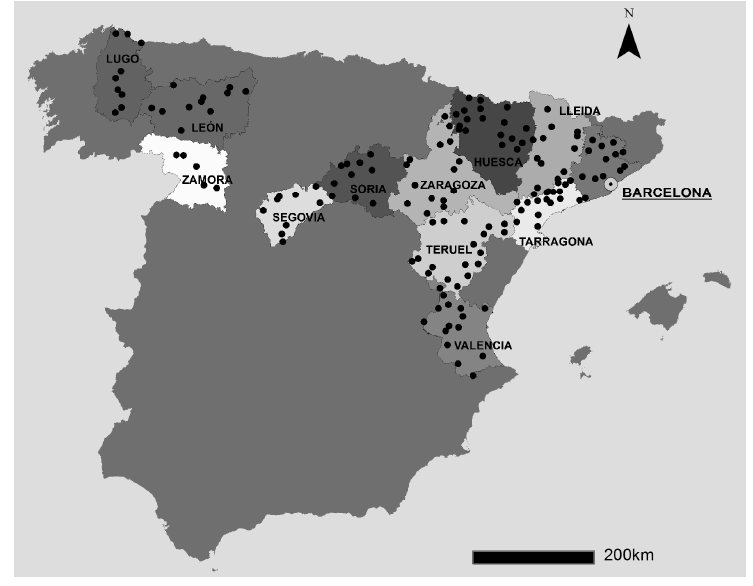
Figure 1. Map with the weather stations considered in this